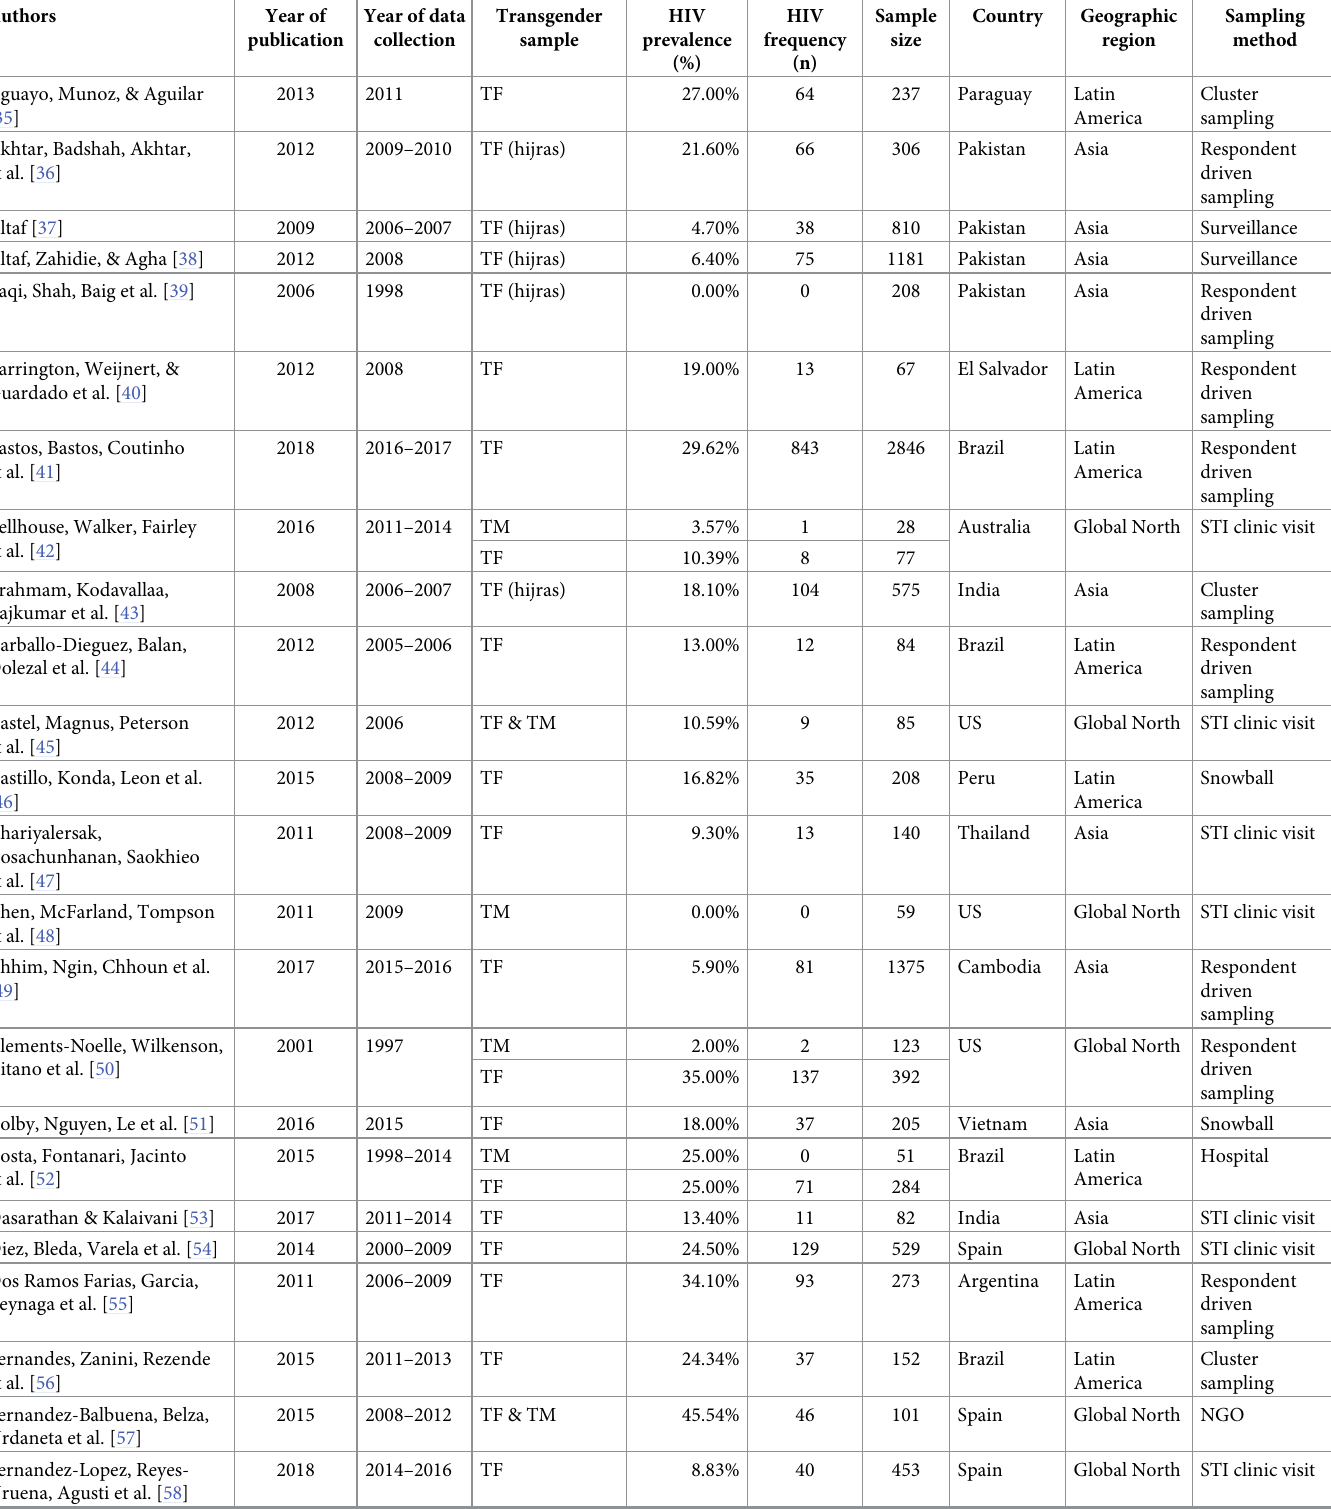
Table 1. Studies included in review and